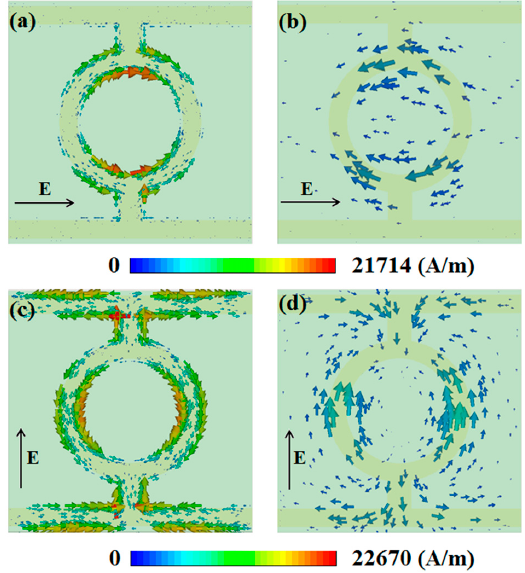
Figure 4. Simulated surface current distribution on ( a ) the patterned copper layer at 238.4 GHz under TE-polarized incidence, ( b ) the copper ground plane at 238.4 GHz under TE-polarized incidence, ( c ) the patterned copper layer at 313.2 GHz under TM-polarized incidence, and ( d ) the copper ground plane at 313.2 GHz under TM-polarized incidence.